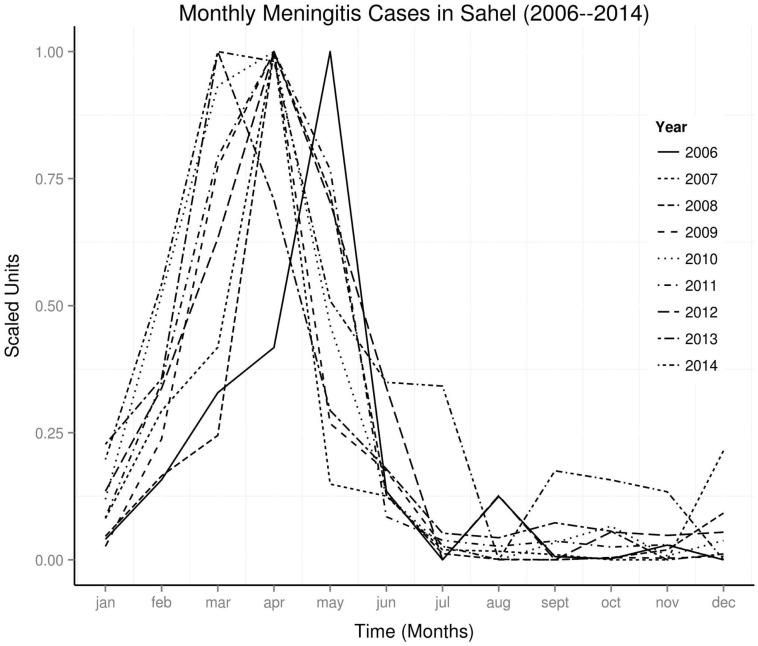
Seasonal peaks of occurrence in Sahel.